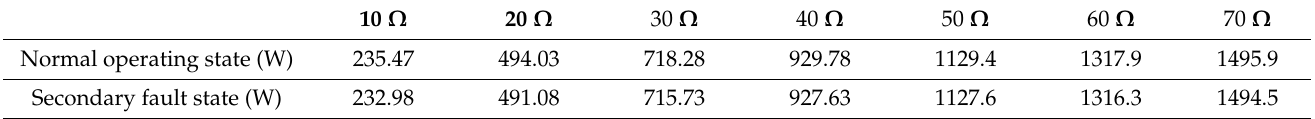
Table 4. Output power of different loads in the normal operating state and after secondary side coil